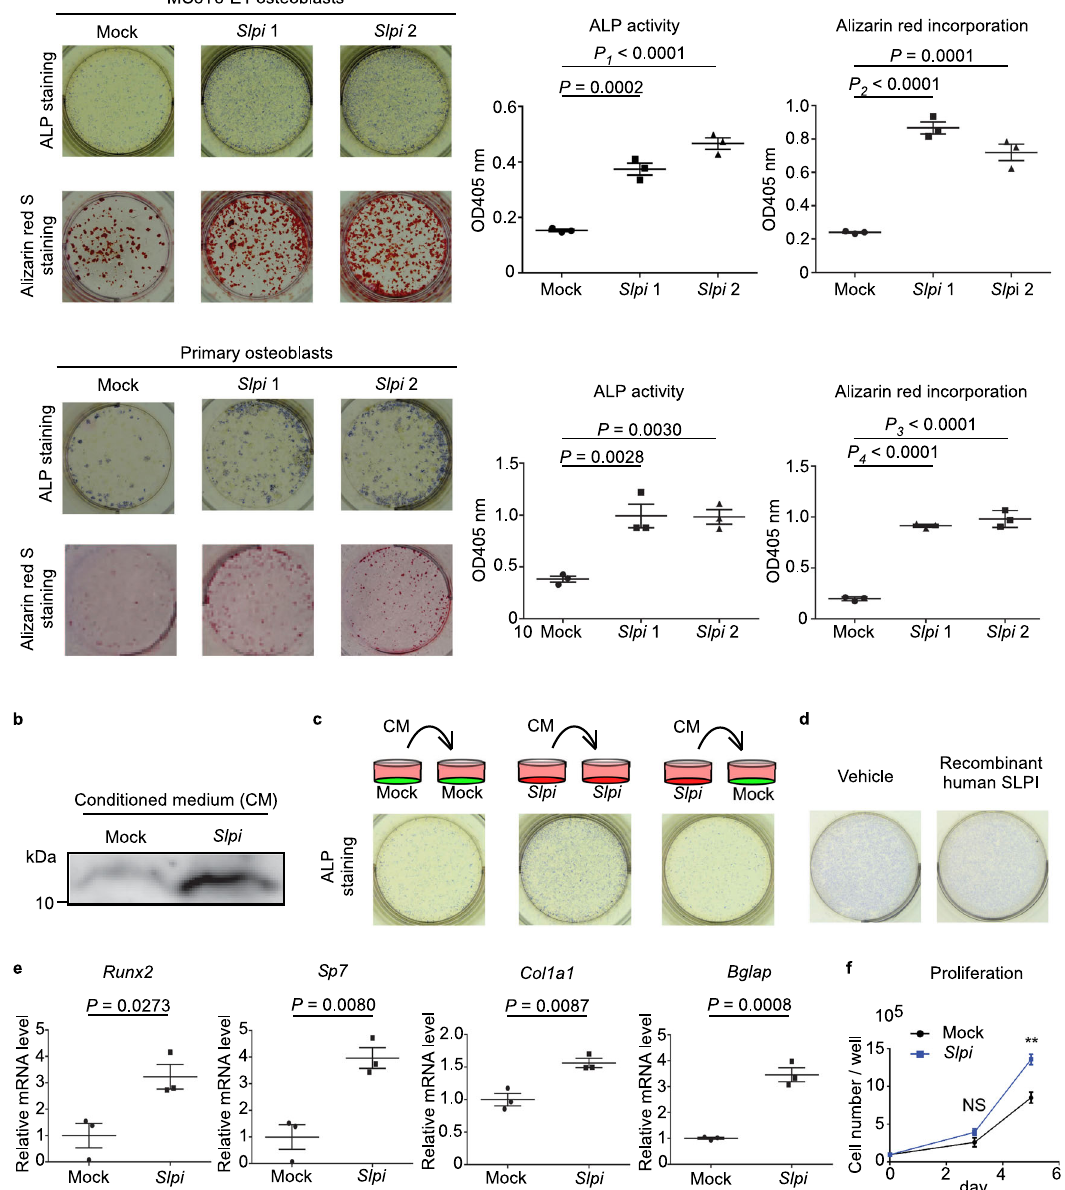
Fig. 2 Induction of Slpi enhances osteoblast differentiation and proliferation. a Representative images of MC3T3-E1 and primary mouse calvarial osteoblasts transfected with either pMX- Slpi -IRES-puro or pMX-IRES-puro by alkaline phosphatase (ALP) staining (upper) and Alizarin Red S staining (lower) ( n = 3 biological replicates per group). β -glycerophosphate was used at a concentration of 10 mM. b , Immunoblot of SLPI in conditioned medium from control MC3T3-E1 and Slpi -overexpressing cells (Representative blot, n = 2 biologically independent experiments). c Typical images of ALP staining of MC3T3-E1 cells. Control (mock) or Slpi overexpressing (Slpi) MC3T3-E1 cells were treated with mock or Slpi conditioned medium under osteogenic conditions for 3 days. d ALP-stained images of MC3T3-E1 cells treated with vehicle or human recombinant SLPI (10 µ g/mL) under osteogenic conditions for 3 days. e qPCR analysis of MC3T3-E1 cells transfected with pMX- Slpi -IRES-puro or pMX-IRES-puro ( n = 3 biological replicates per group). Cells were cultured in osteogenic differentiation medium for 3 days, and the expression levels of osteoblast transcript regulators ( Runx2 , Sp7 ) and